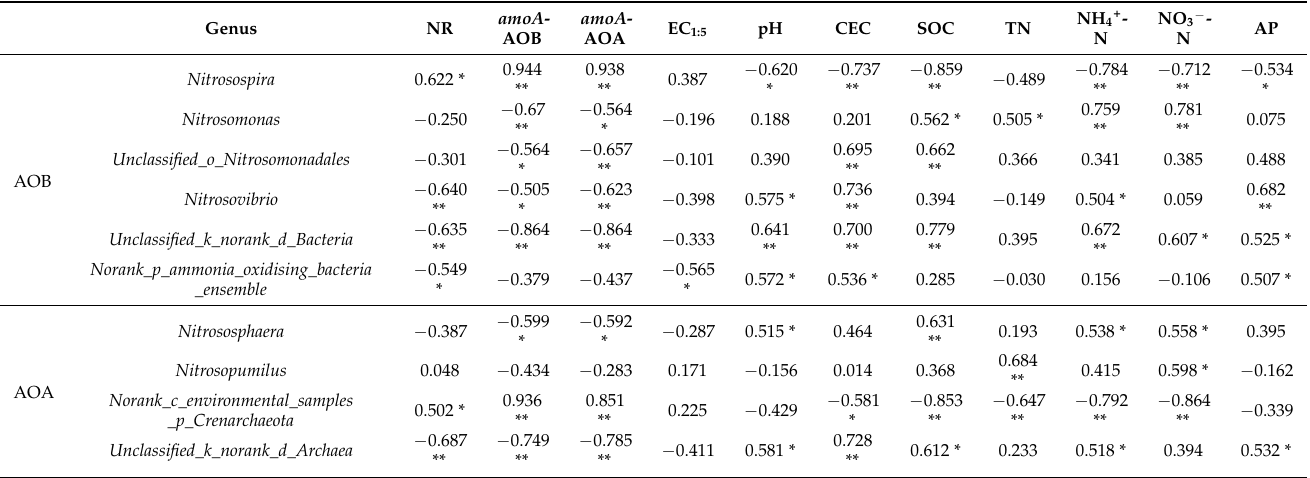
Table 5. Spearman’s rank correlations between the relative abundances of dominant genera of AOB and AOA, and nitrification rate, gene copies of amoA -AOB and amoA -AOA, and the soil basic prop- erties ( n = 15).